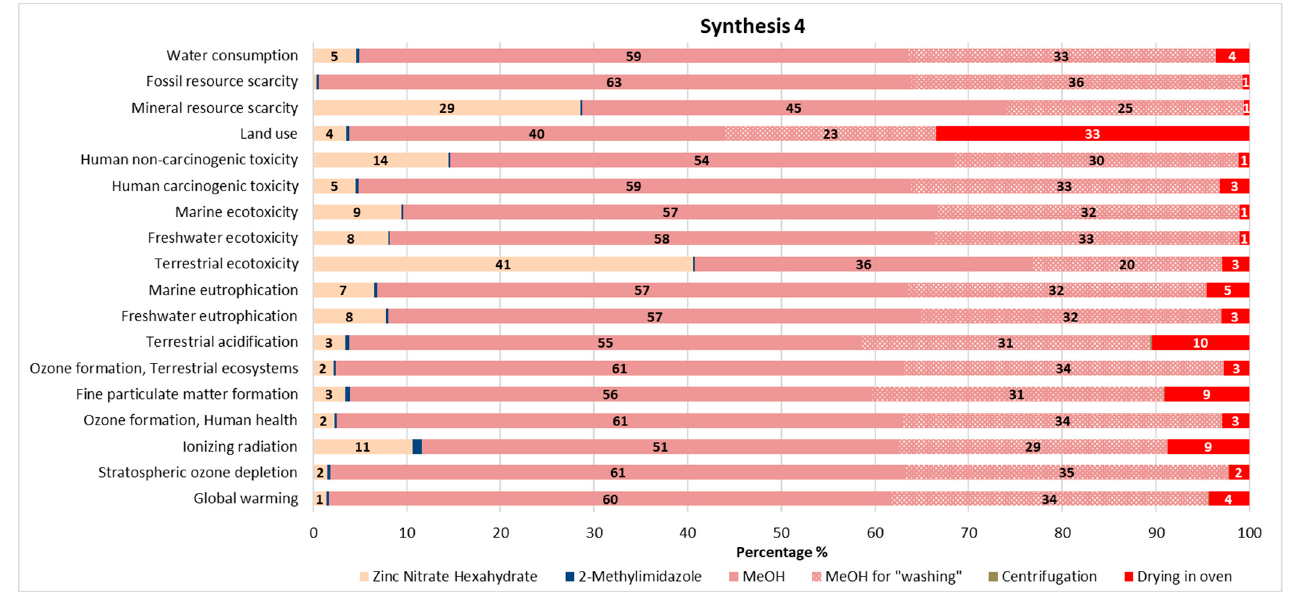
Energies 2021 , 14 , x FOR PEER REVIEW Figure 6. Life Cycle Assessment of the 3rd synthetic approach of ZIF-8. Method: ReCiPe 2016, midpoint (H) V.1.01.